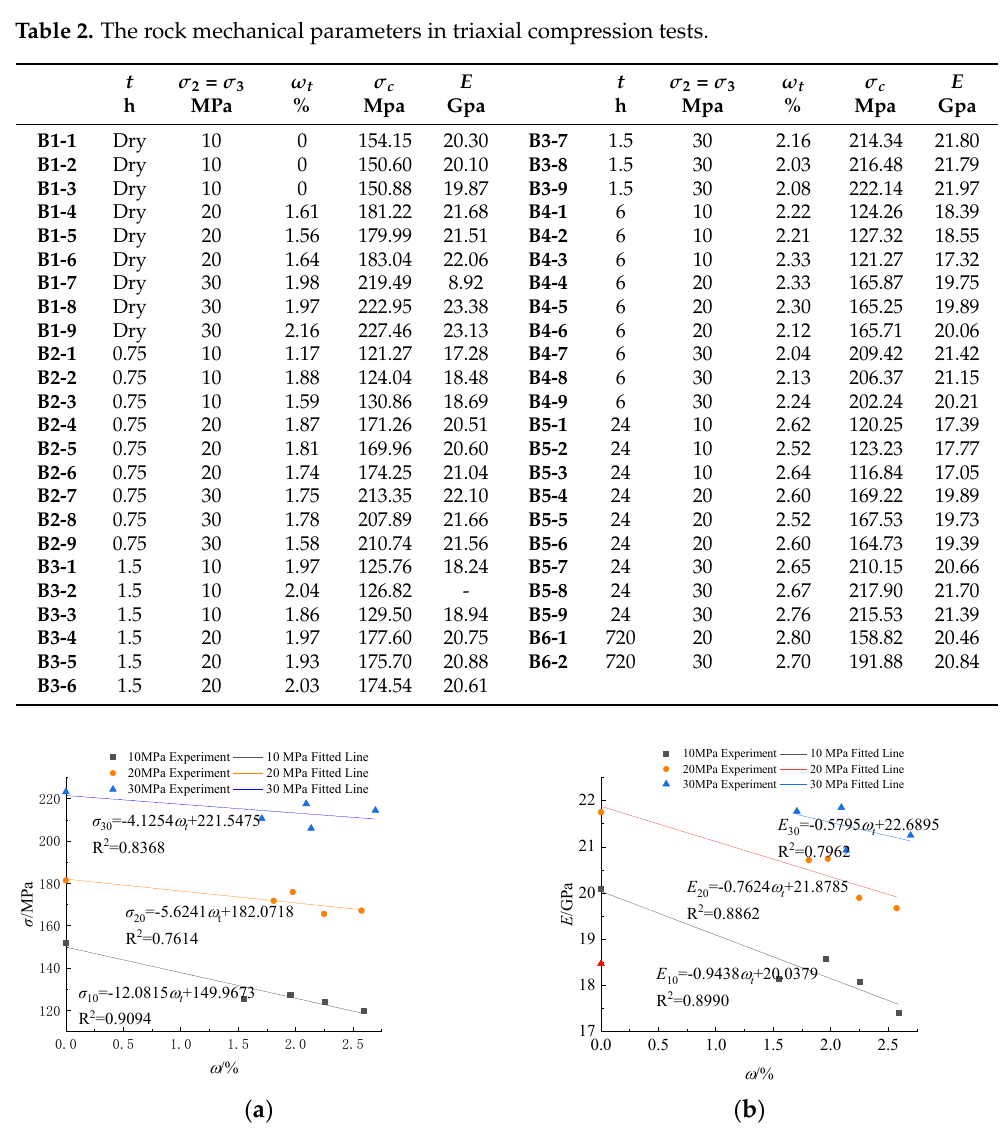
Figure 7. The correlation between water content and mechanical parameter in triaxial test. ( a ) σ - ω ; ( b ) E- ω .